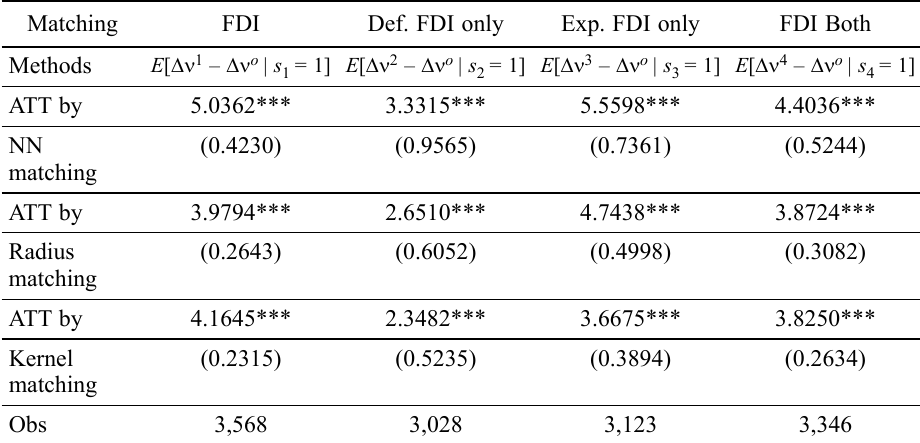
Table 5. Estimation of average treatment effect on the treated (outcome variable: rate of innovation